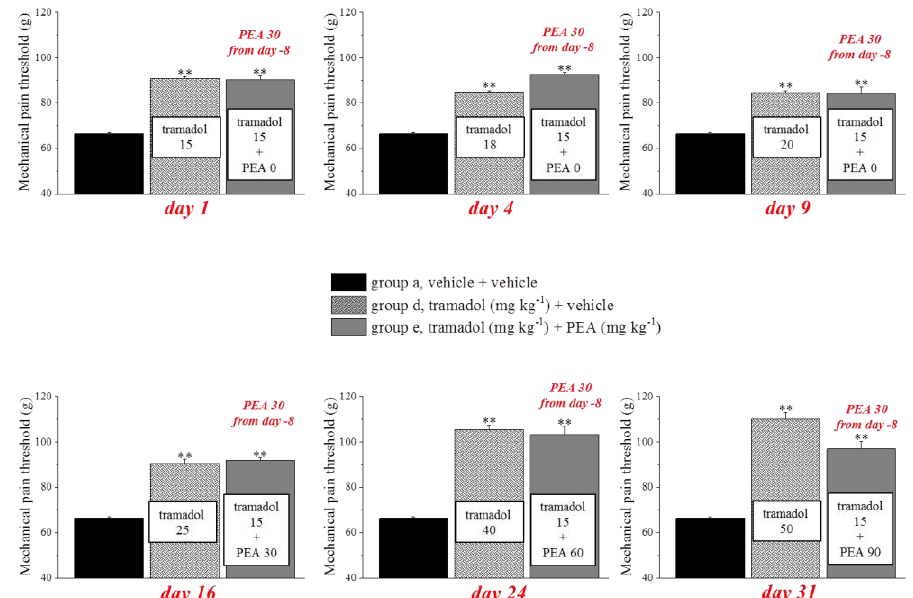
Figure 6. Antinociceptive effects of different combinations of tramadol and PEA. Rats were treated with the vehicle (Groups a and d) or pre-emptive PEA (30 mg kg −1 in the evening; Group e) per os daily for the duration of the experiment, starting on Day − 8. To maintain a pain threshold of about 90 ± 10 g, beginning on Day 1, increasing daily doses of tramadol (15 – 50 mg kg −1 ) were injected s.c. into Group d. Different combinations of oxycodone (15 mg kg −1 , s.c.) and PEA (30 – 90 mg kg −1 , p.o.) were administered to Group e. Measurements were conducted every day in the morning, before and 30 min after tramadol and/or acute PEA administration. Representative results obtained 30 min after treatments on Days 1, 4, 9, 16, 24 and 31 are shown. The results are expressed as mean ± SEM of values from 12 rats analysed in two different experimental sets. Statistical analysis was one-way ANOVA followed by Bonferroni’s post hoc comparison. ** p < 0.01 vs. vehicle + vehicle group. The protocol adopted for the study involving tramadol made it necessary to use 15 mg kg − 1 of the opioid in both groups (tramadol + vehicle and tramadol + PEA) on Day 1 to increase the animal’s pain threshold up to 90 g ( p < 0.01). On Day 4, 18 mg kg − 1 of tramadol